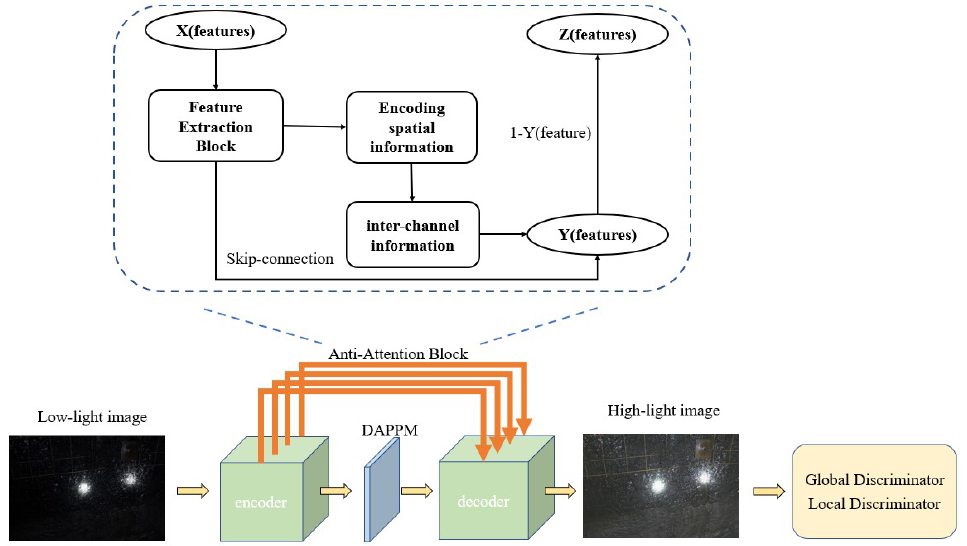
Figure 2. Overview of our generator